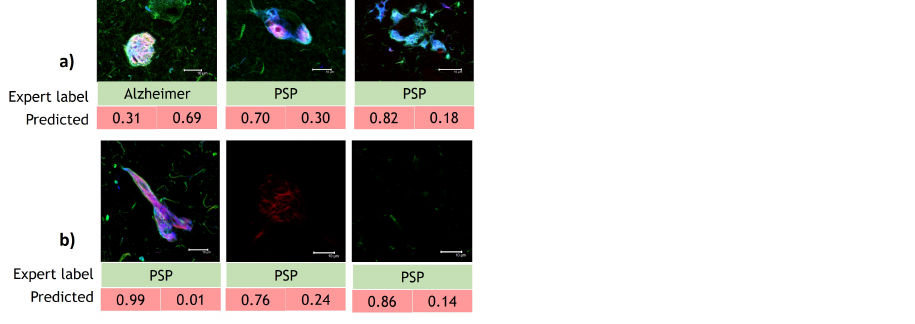
Figure 9. Unique misclassified images using ResNet-IFT architecture. ( a ) Model developed using D1. ( b ) Model developed using